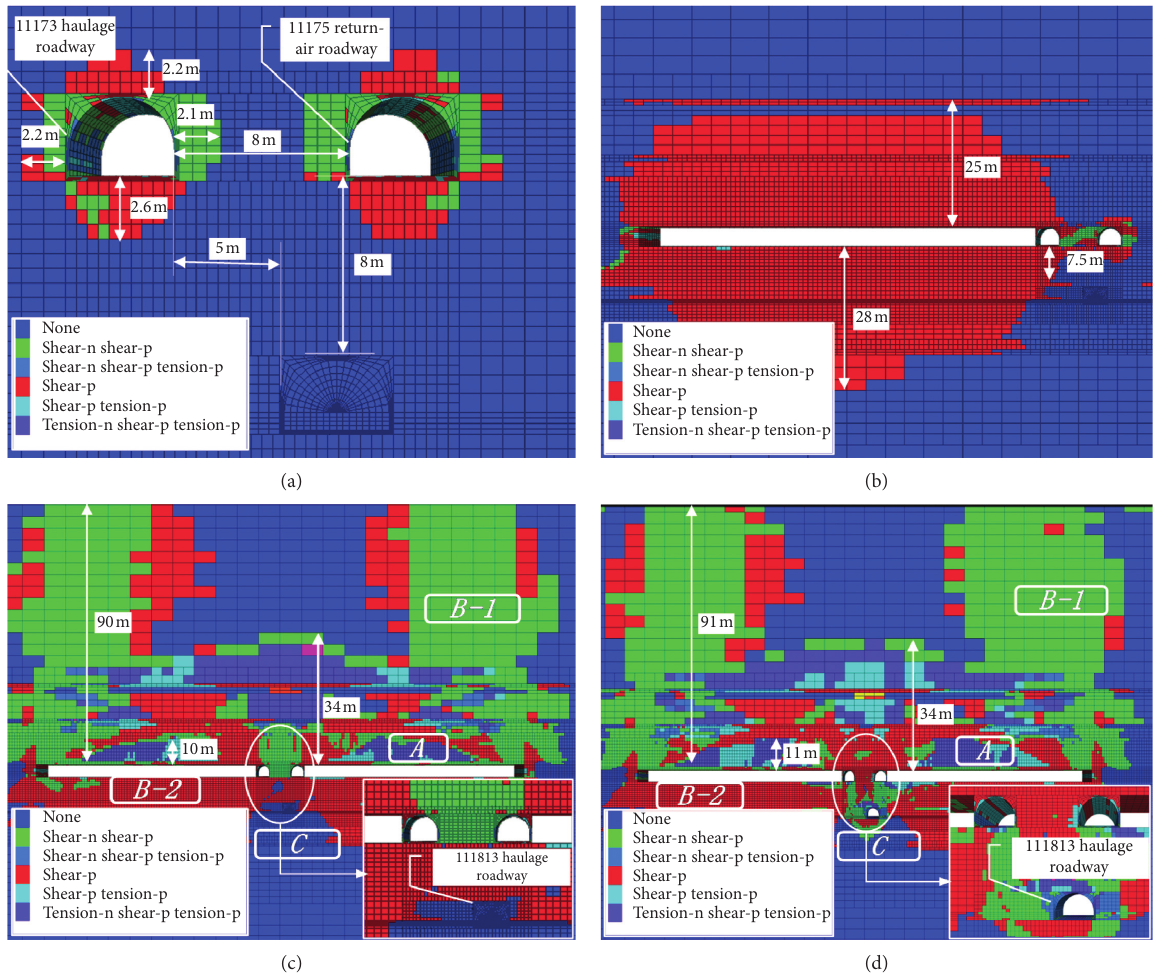
Figure 4: Distribution of the plastic zone of the surrounding rock in different stages of mining and excavation. (a) The mining roadway is excavated. (b) The 11173 mining face is mined out. (c) The 11173 mining face is mined out. (d) The 1118 1 3 haulage roadway is